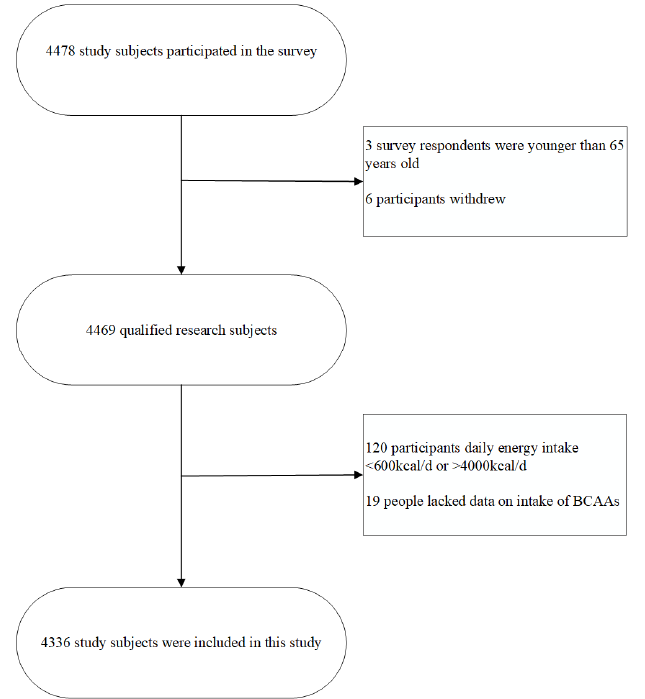
Figure 1. Flow chart.